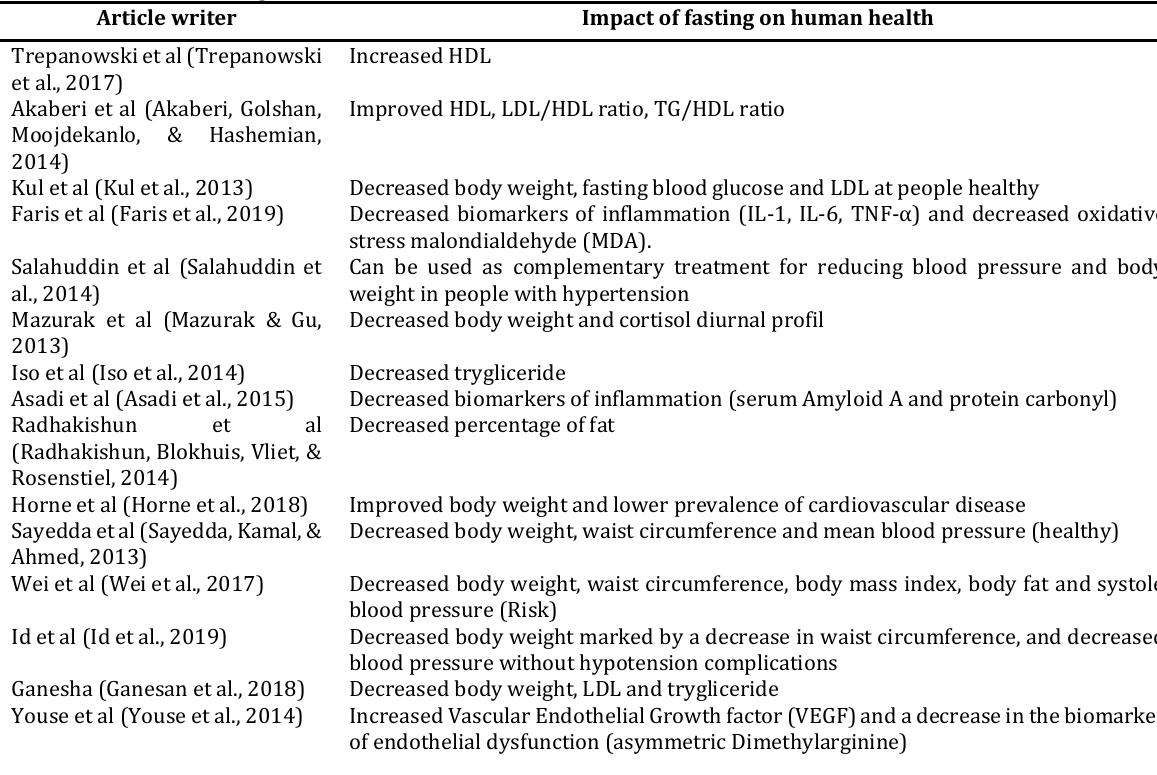
Table 1. Benefit of fasting on human health